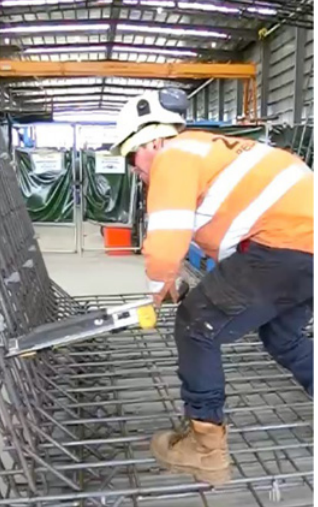
Use of the long handled stapler tool at ankle to knee level When used between ground and shoulder heights, use of the long handled stapler tool produced lower mean trunk inclination scores. However, when used above shoulder height, the long handled stapler tool involved higher extension (backward bending) of the trunk. Mean trunk inclination scores were also significantly different between the power tying tool and the long handled stapler tool (p < 0.05). At all work heights the power tying tool produced higher mean trunk inclination scores than the stapler tool. At all work heights, except ankle